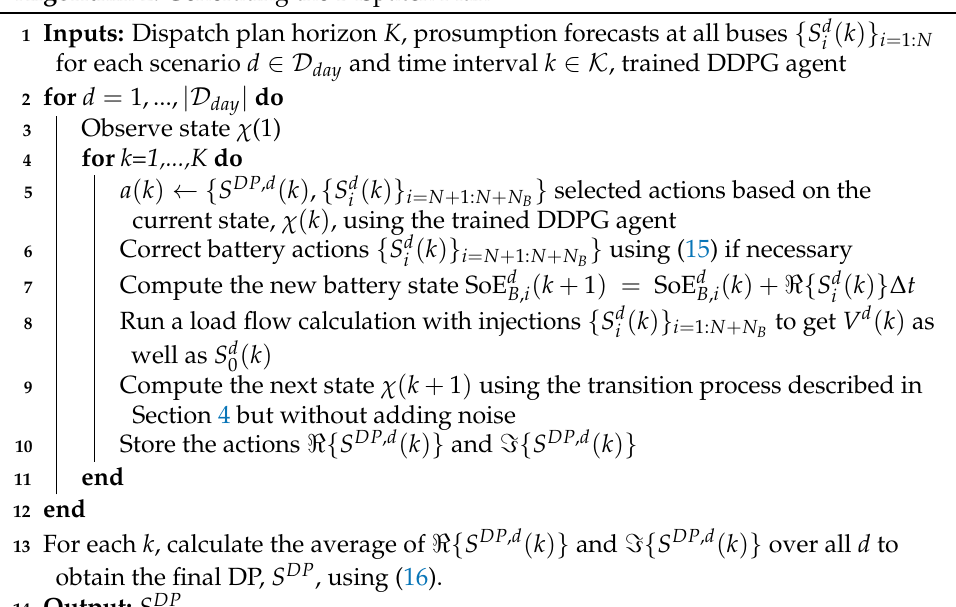
Algorithm 2: Generating the Dispatch